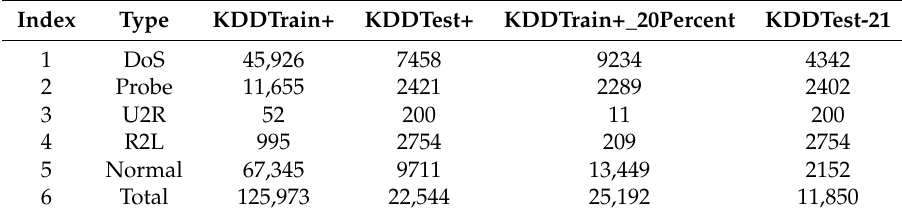
Table 5. The specific data distribution of four datasets.